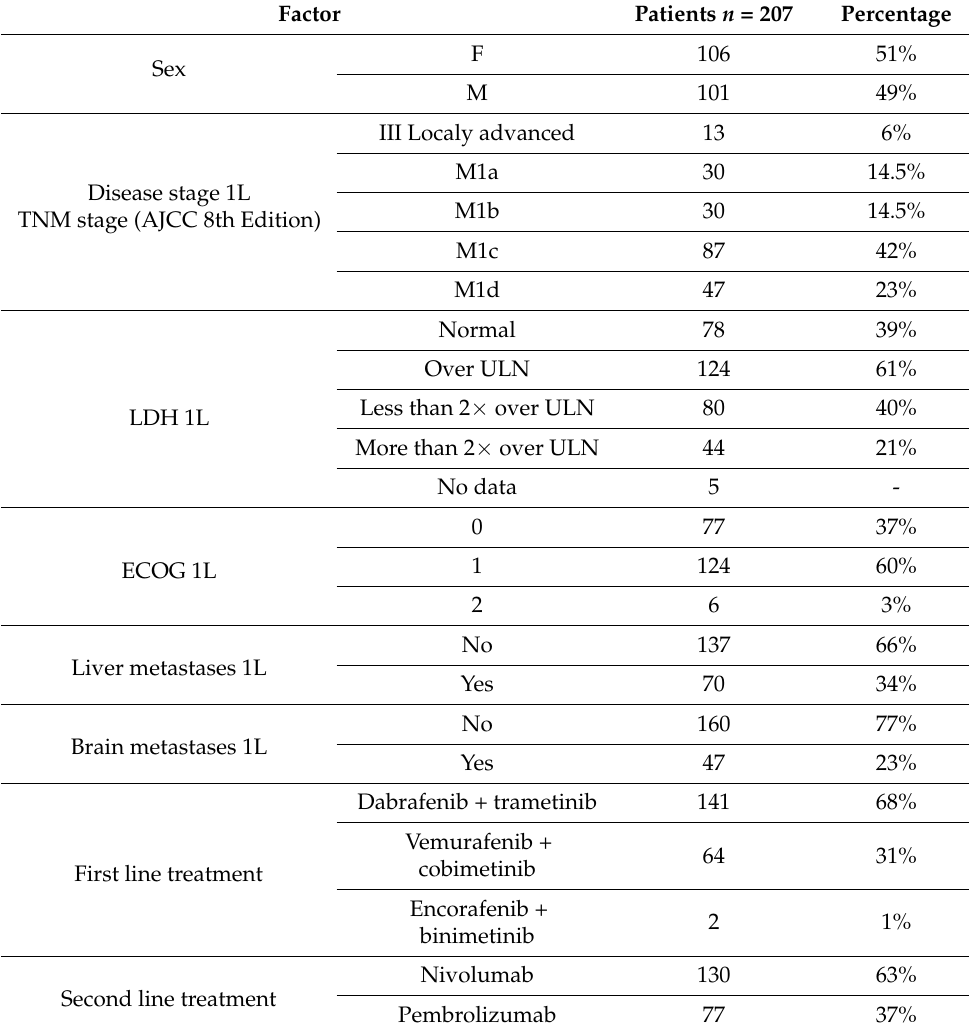
Table 1. Baseline patients characteristics.